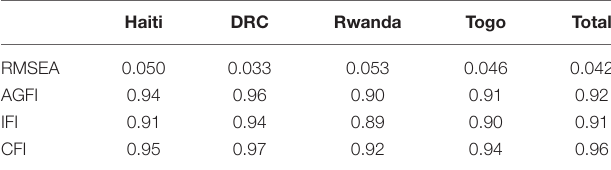
TABLE 3 | Confirmatory factorial results over countries.